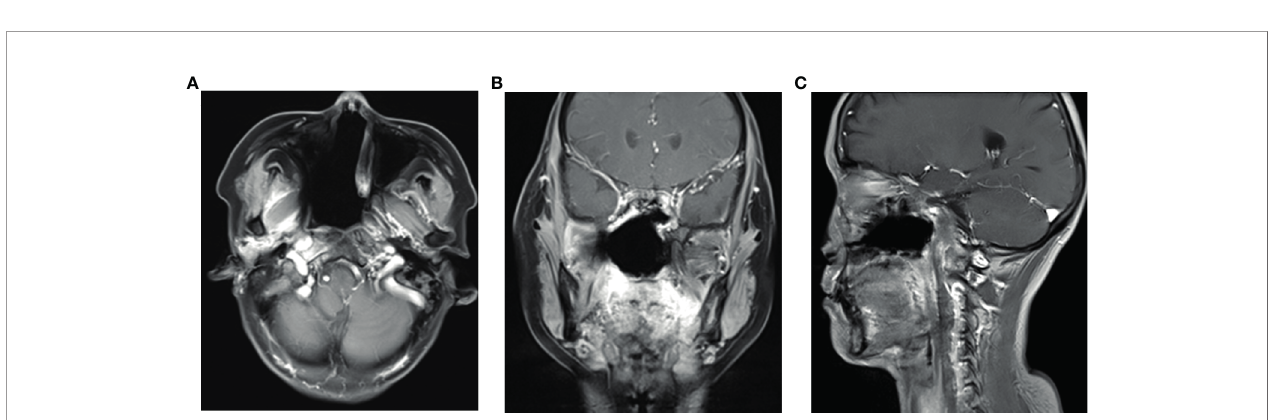
FIGURE 2 | (A) H&E staining of local canceration of the inverted papilloma (×100); (B) H&E staining of local canceration of the inverted papilloma (×400).